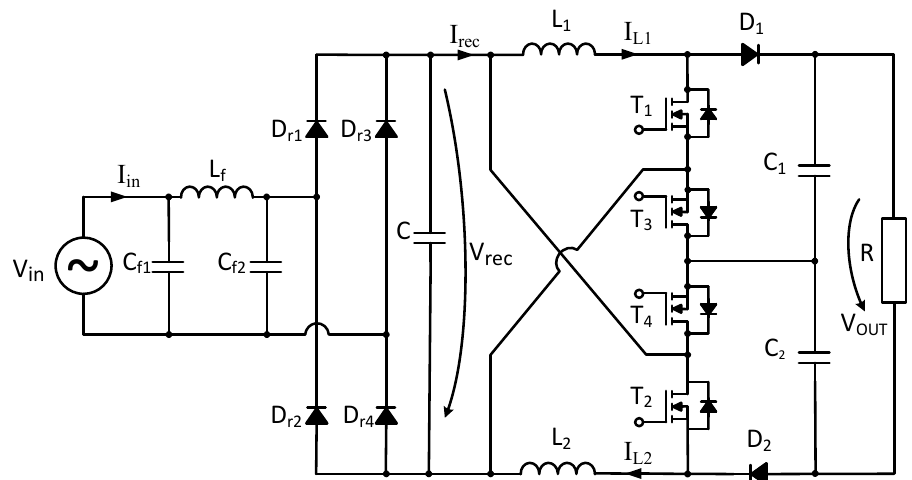
Figure 1. The electronic schematic of the proposed converter. V in —main input voltage; V rec —rectified voltage; V out —DC output voltage; I rec —rectified current; I in —input current; and I L1 and I L2 –L 1 and L 2 inductor currents.